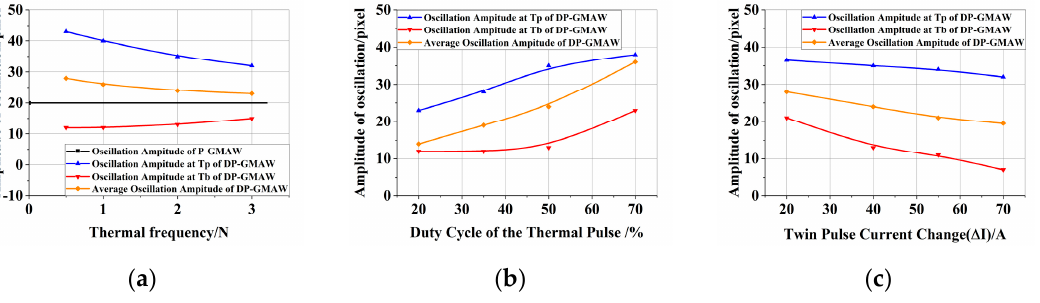
Figure 15. Variation of weld pool oscillation amplitude with ( a ) heat thermal frequency; ( b ) duty cycle of the thermal pulse; ( c ) current amplitude of thermal pulse.